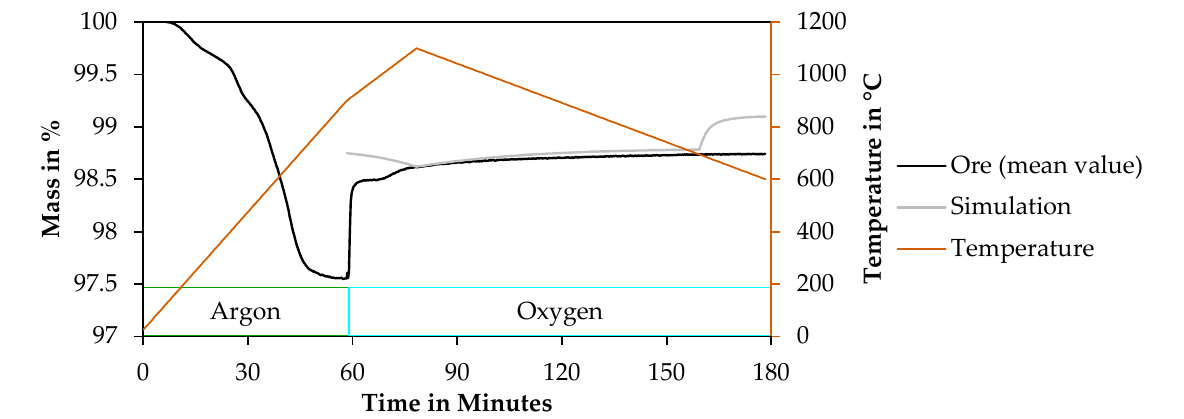
mass gain of the chromite sample according to the thermochemical simulation carried out